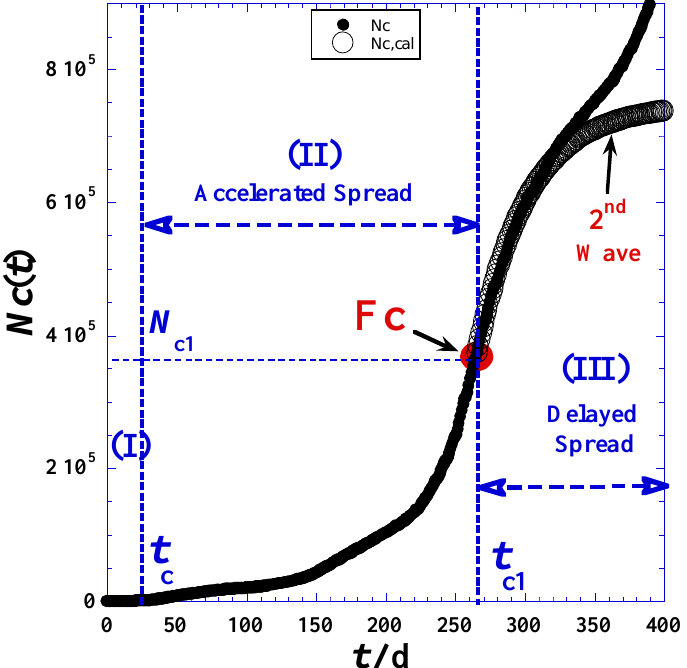
Figure 6. Total reported cases Nc ( t ) for the first 400 days for delayed phase (III) in symmetric behavior using Equation (14) and τ c ’ = 46 days.